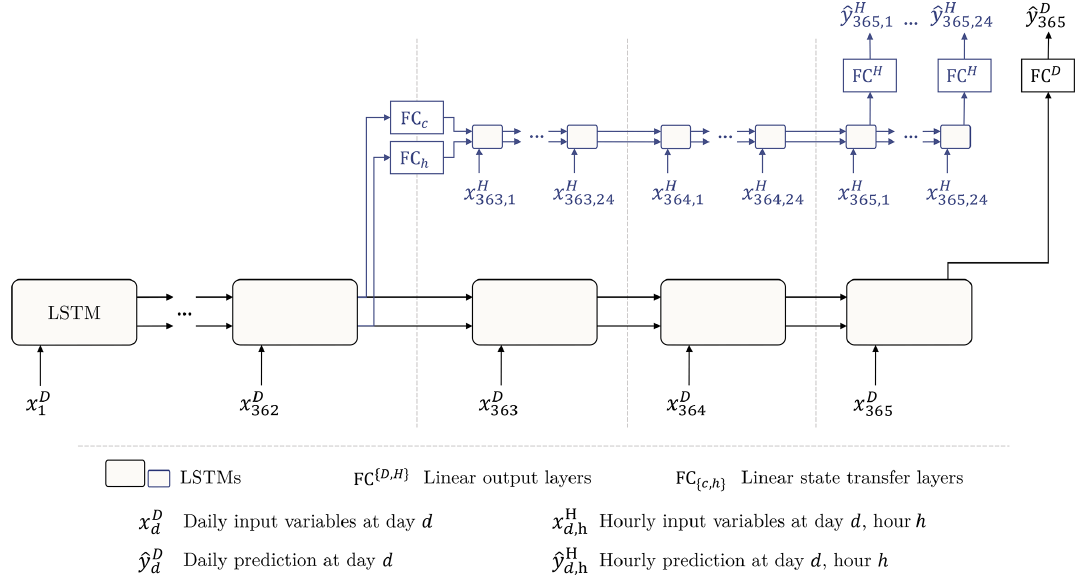
Figure 2. Illustration of the MTS-LSTM architecture that uses one distinct LSTM per timescale. In the depicted example, the daily and hourly input sequence lengths are T D = 365 and T H = 72 (we chose this value for the sake of a tidy illustration; the benchmarked model uses T H = 336). In the sMTS-LSTM model (i.e., without distinct LSTM branches), FC c and FC h are identity functions, and the two branches (including the fully connected output layers FC H and FC D ) share their model